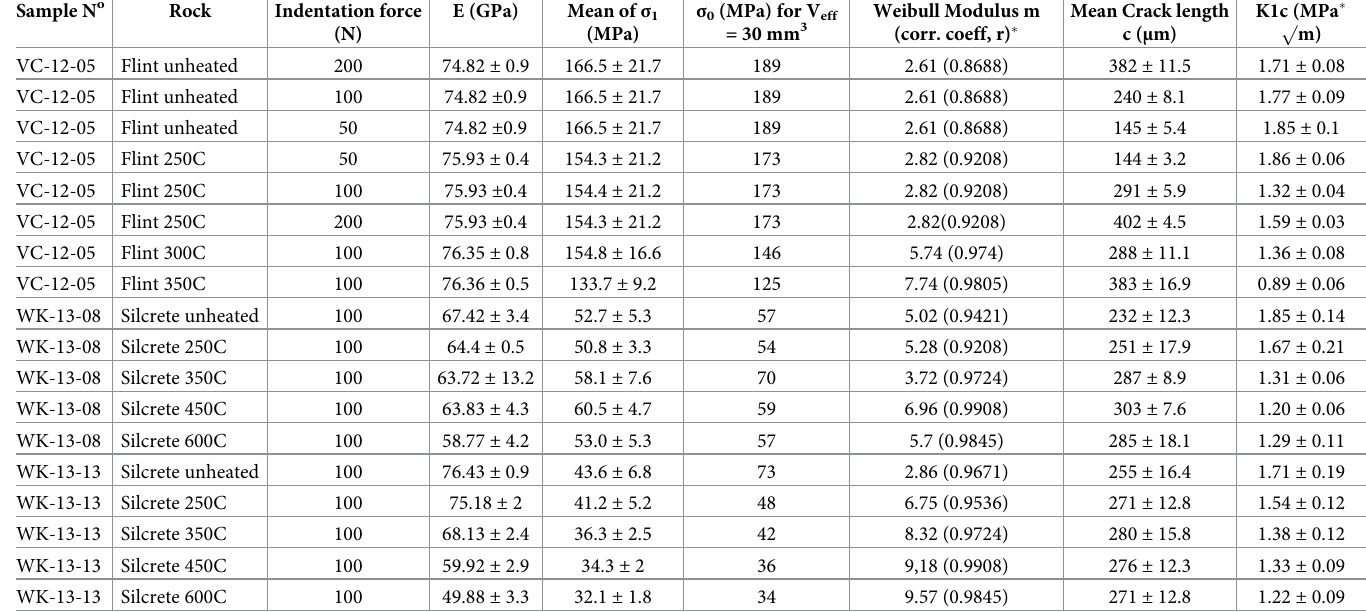
Table 1. Selected data from Schmidt et al. [19] used for this study.